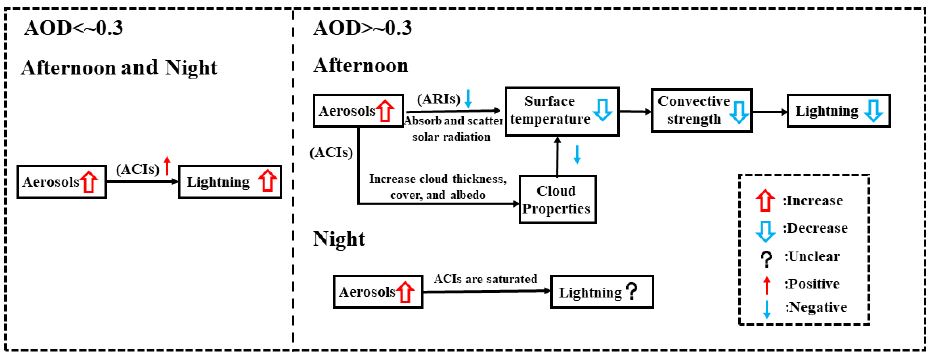
Figure 11. Schematic diagram illustrating the difference in effects of aerosols on lightning activity in the afternoon (12:00–18:00BJT) and at night (23:00–05:00BJT) over the study